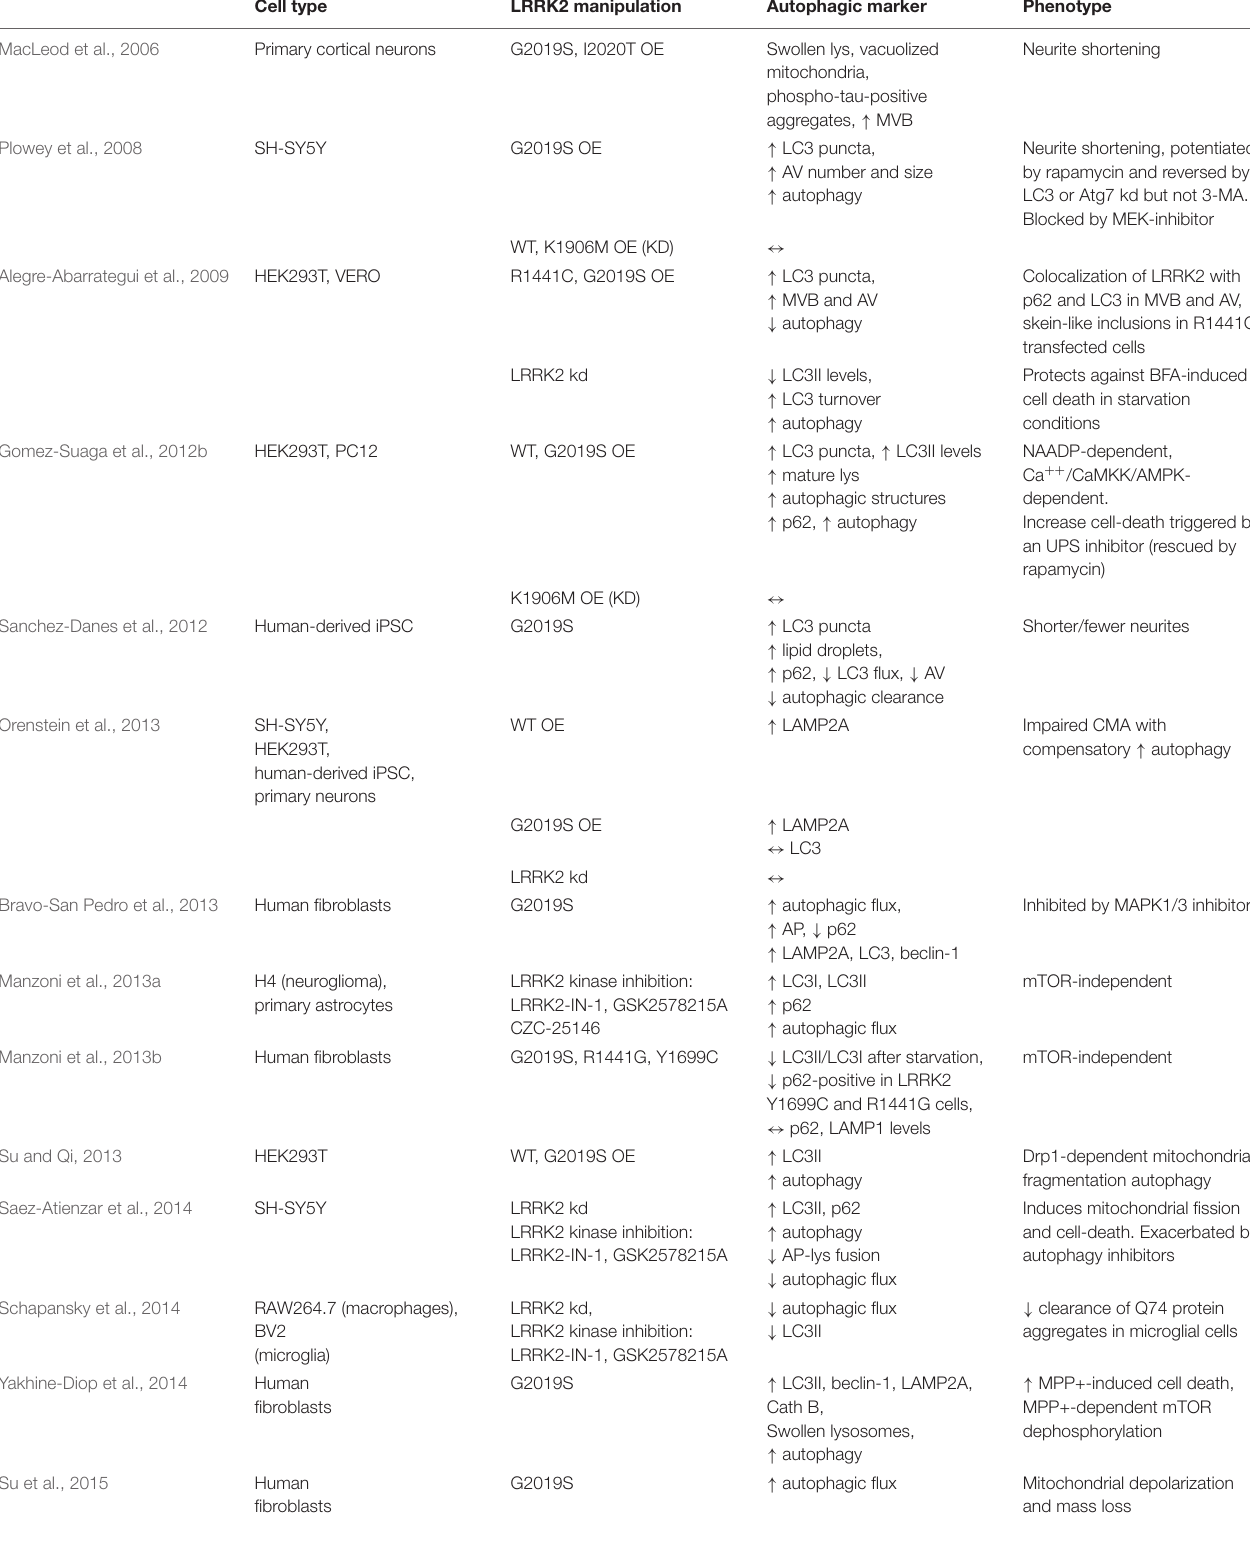
TABLE 1 | Synopsis of the in vitro studies investigating the impact of genetic and pharmacological manipulation of LRRK2 on autophagy and its